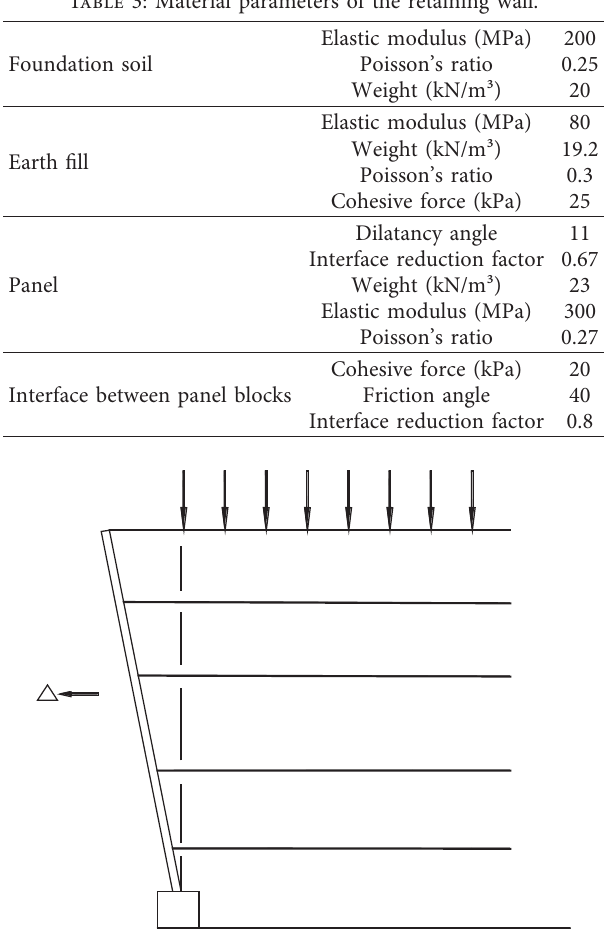
Figure 2: Schematic diagram of lateral deformation shape of the wall panel.